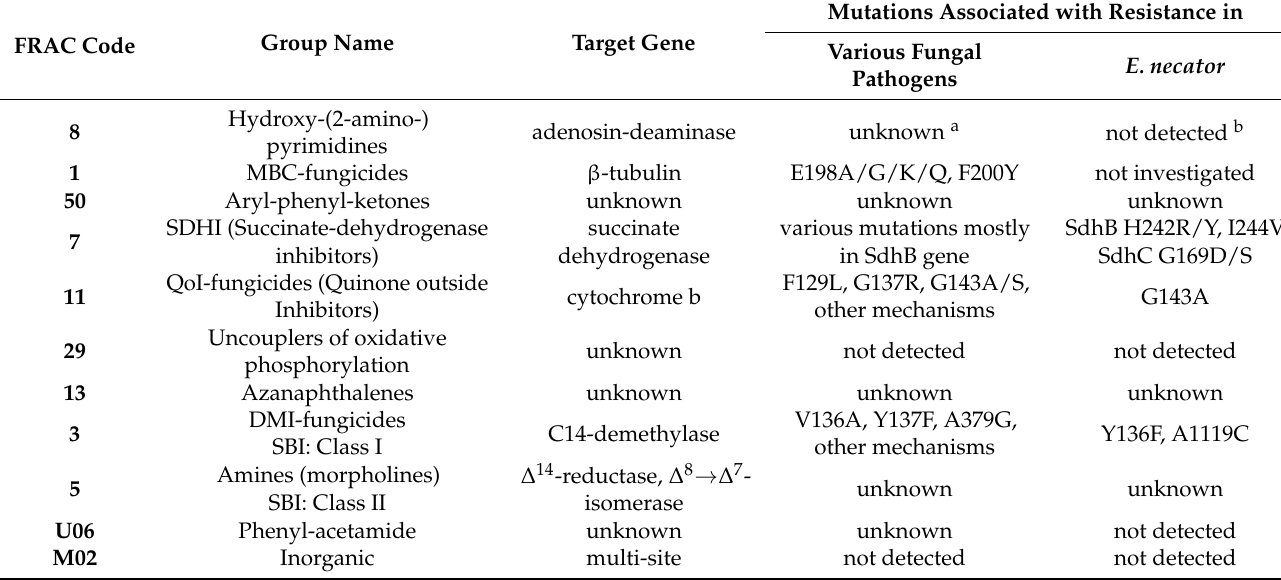
Table 2. Molecular mechanisms of resistance to fungicides applied in grapevine powdery mildew management. Target gene and single-nucleotide mutations described in various fungal pathogens and grapevine powdery